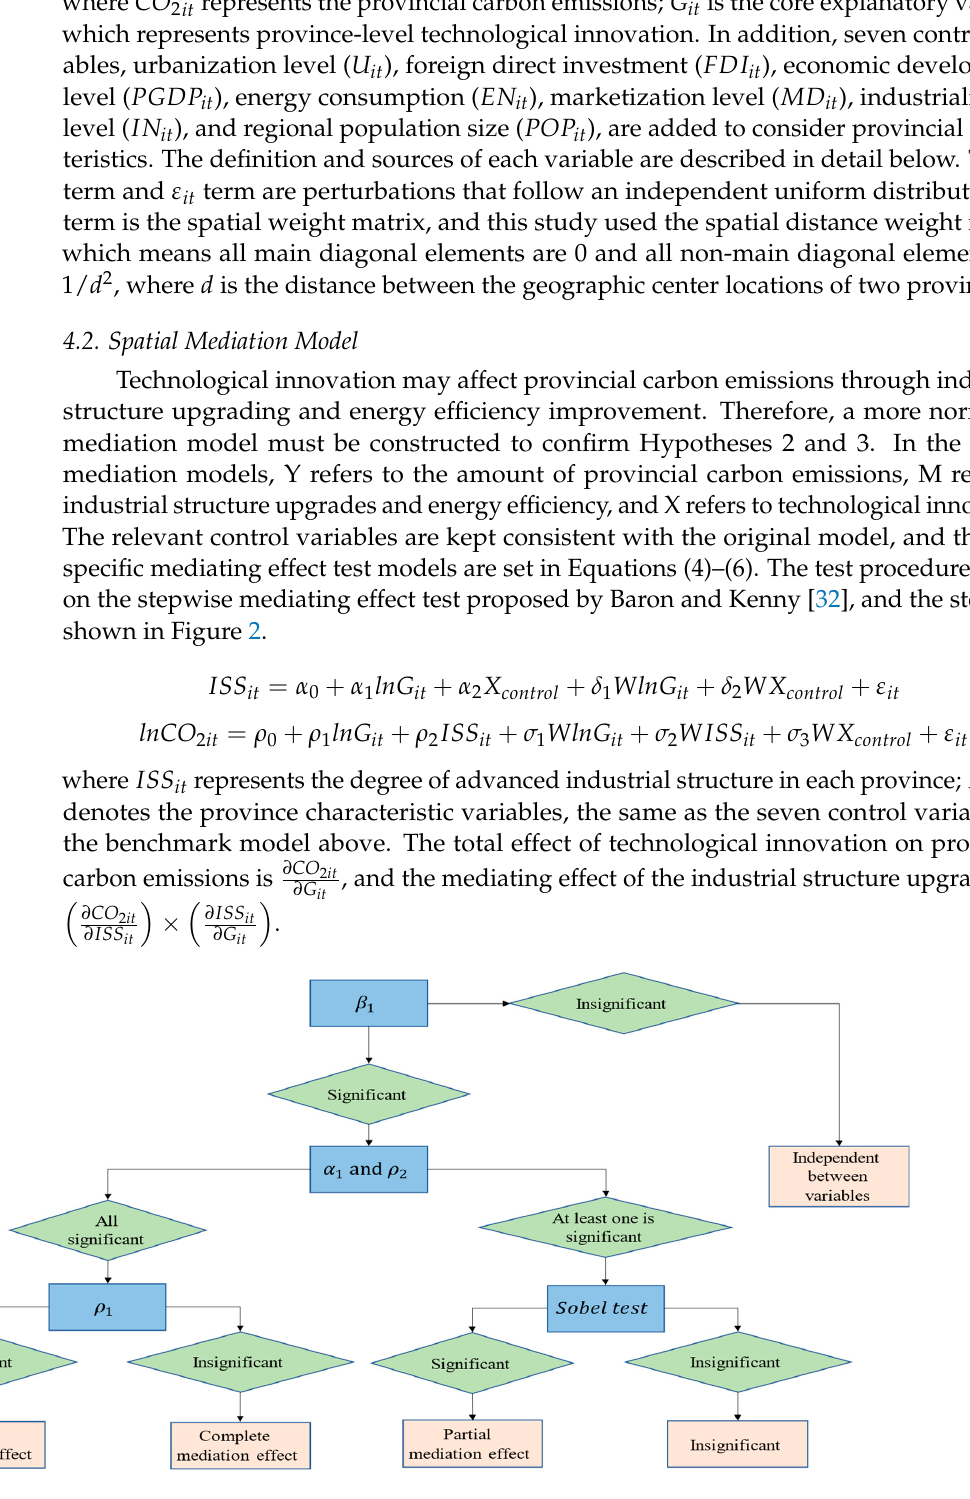
Figure 2. Flowchart of mediating effect test.